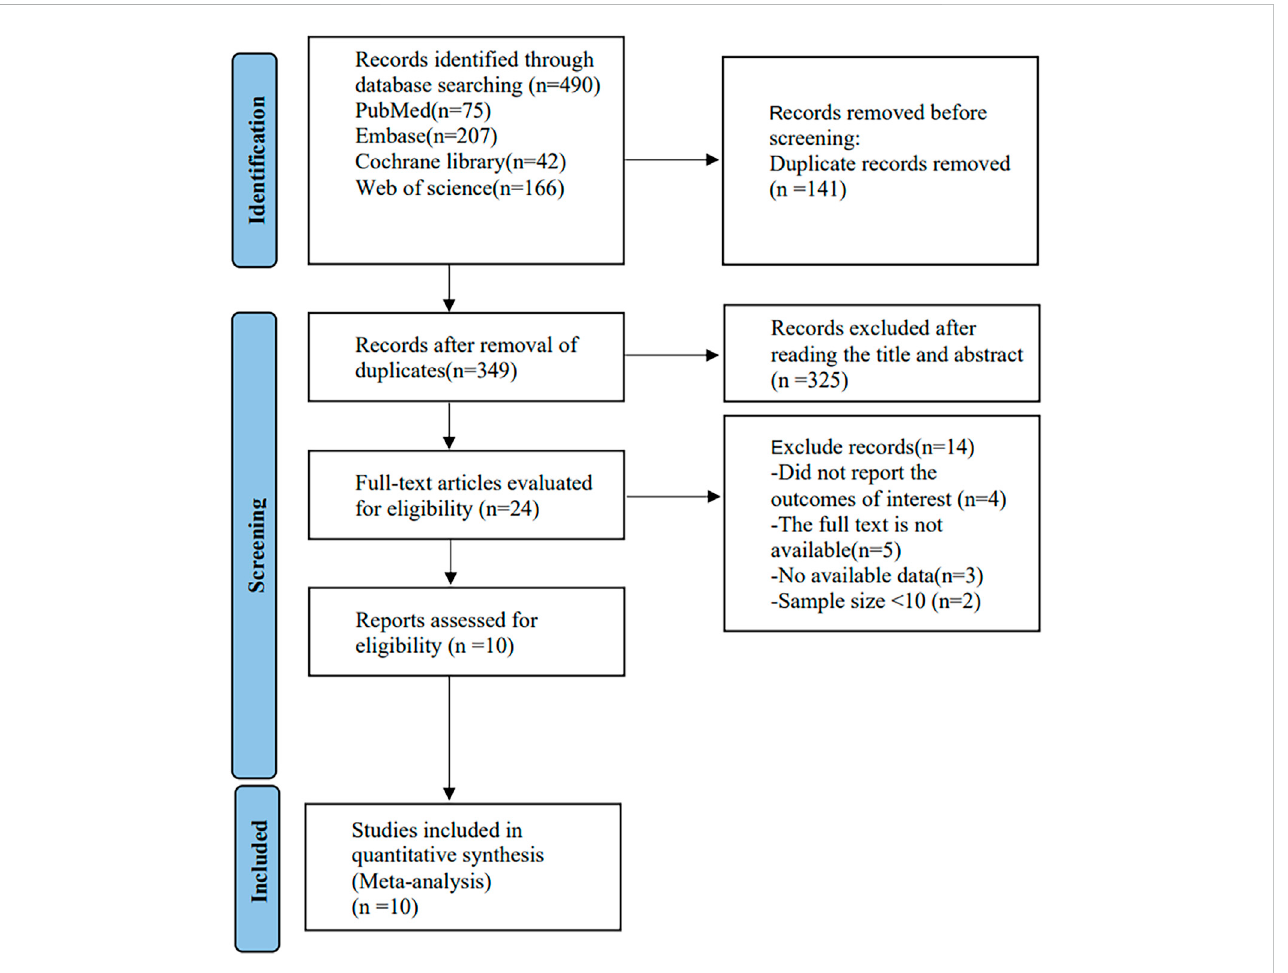
FIGURE 1 Literature screening fl